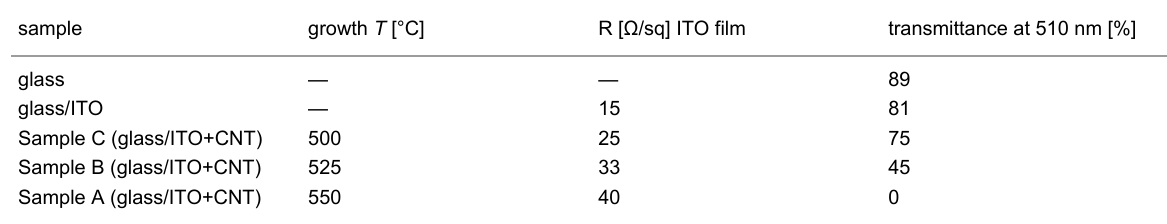
Table 1: Growth parameters and properties for the three CNT-enhanced electrodes compared to pure glass and to ITO/glass sample. sample